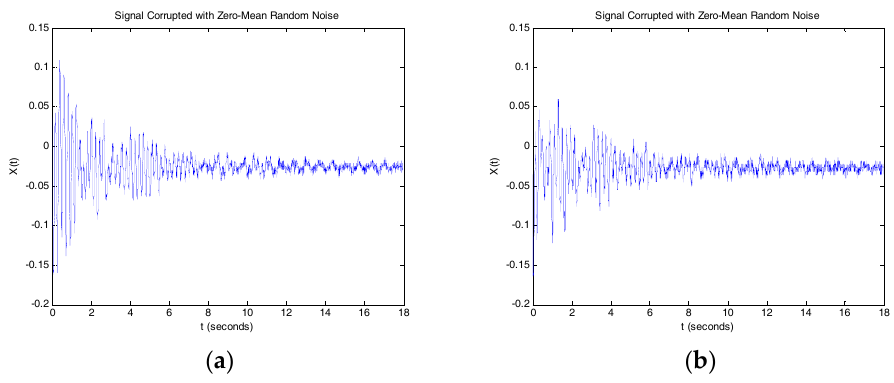
Figure 7. Tiltmeter reading for trucks left bridge. ( a ) Tiltmeter 1 signal; ( b ) Tiltmeter 2 signal.